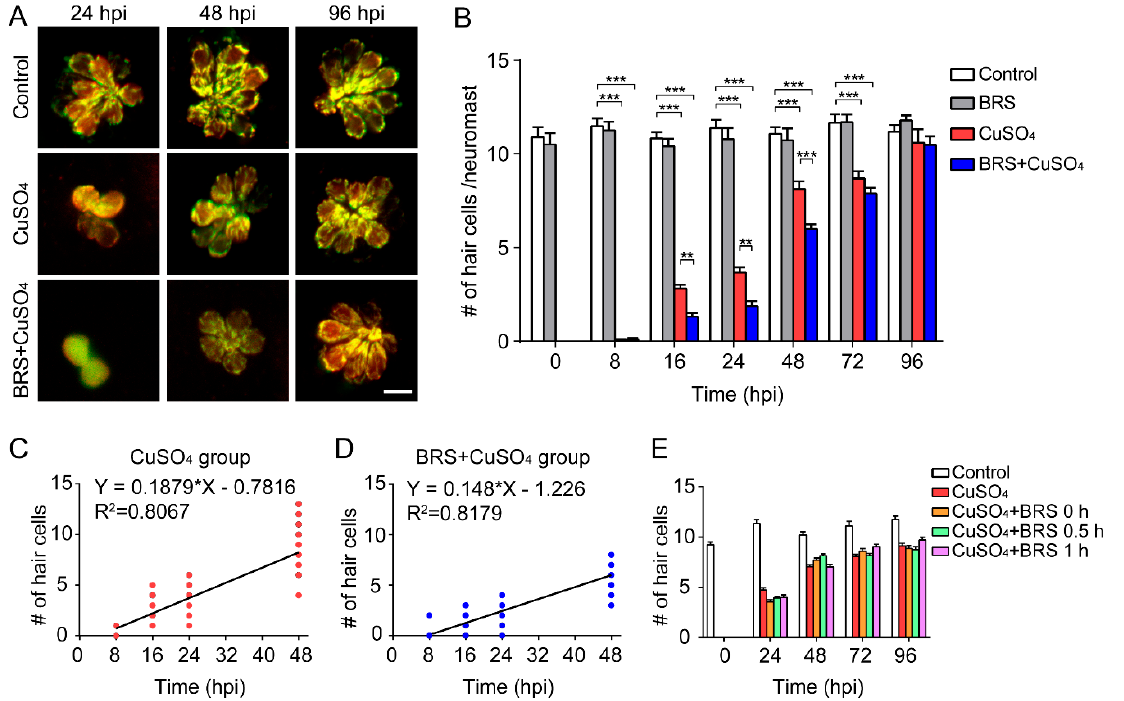
Figure 3. Suppressing inflammation delays hair cell regeneration. ( A ) Real-time imaging (40 × ) displays regenerated hair cells in the CuSO 4 and BRS + CuSO 4 group at 24, 48, and 96 hpi. The control group was imaged at the same time points. Scale bar represents 10 µ m. ( B ) The numbers of regenerated hair cells were significantly lower in the BRS + CuSO 4 group compared to the CuSO 4 group at 16 ( n ≥ 27, p < 0.01), 24 ( n ≥ 21, p < 0.01), and 48 ( n ≥ 24, p < 0.001) hpi. At 96 hpi, hair cells in both the CuSO 4 group and the BRS + CuSO 4 group had regenerated to normal levels. Linear analysis in the CuSO 4 group ( C ) and BRS + CuSO 4 group ( D ) was conducted on the number of regenerated cells within 48 hpi. The slope in the CuSO 4 group (0.188) was higher than that in the BRS + CuSO 4 group (0.148), and the x-intercept in the CuSO 4 group (4.160) is higher than that in the BRS + CuSO 4 group (8.287). ( E ) When the time window of inflammatory suppression was delayed, there was no delay in the regeneration of hair cells. BRS-28 was added at the same time as CuSO 4 (CuSO 4 + BRS 0 h group), 30 min after the addition of CuSO 4 (CuSO 4 + BRS 0.5 h group), or 1 h after the addition of CuSO 4 (CuSO 4 + BRS 1 h group) ( n ≥ 27 neuromasts at each time point of each group). For ( B ) and ( E ), comparisons were performed using two-way ANOVA, with Tukey’ multiple comparisons test. All error bars show the mean ± S.E.M., *** p < 0.001, ** p <